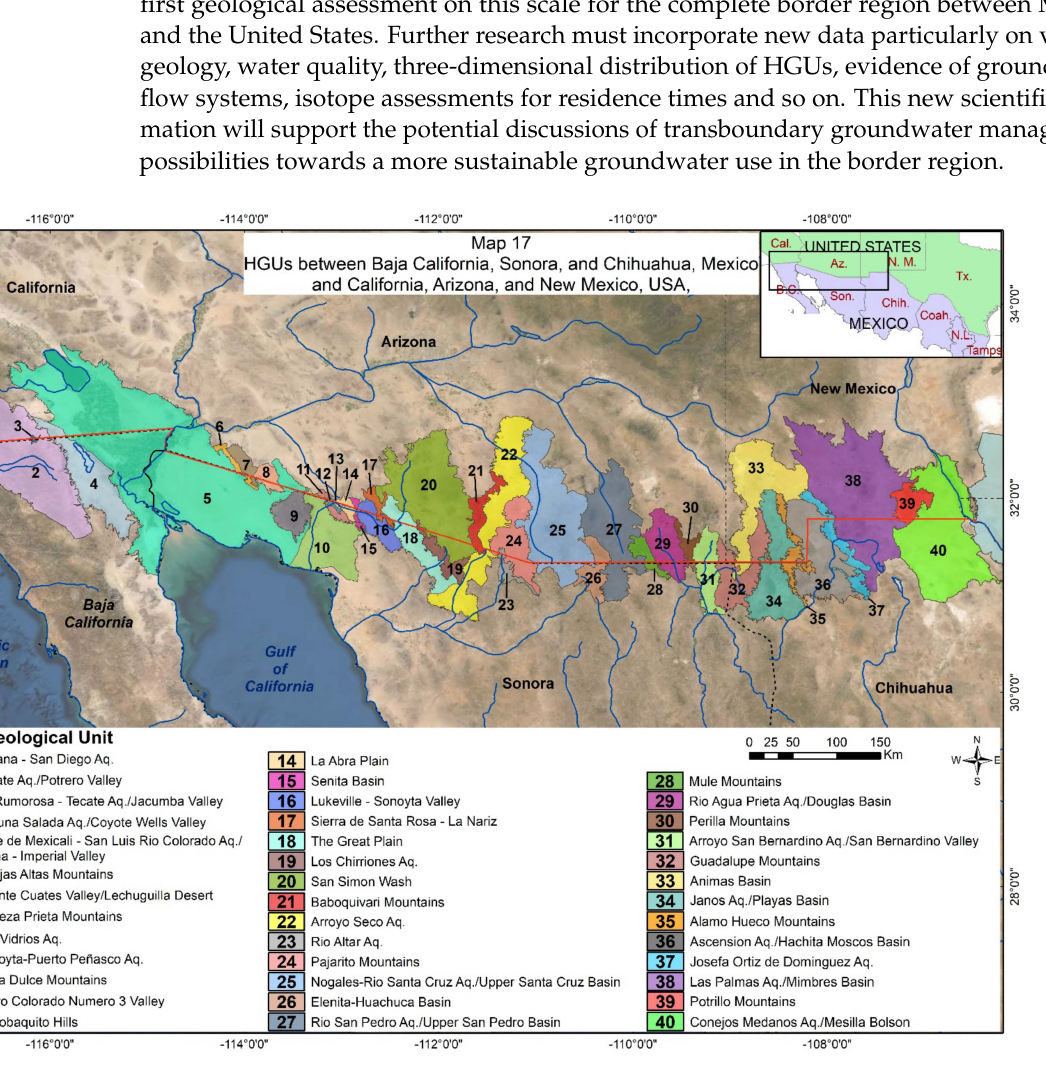
Figure 17. HGUs between Baja California, Sonora, and Chihuahua, Mexico and California, Arizona, and New Mexico,